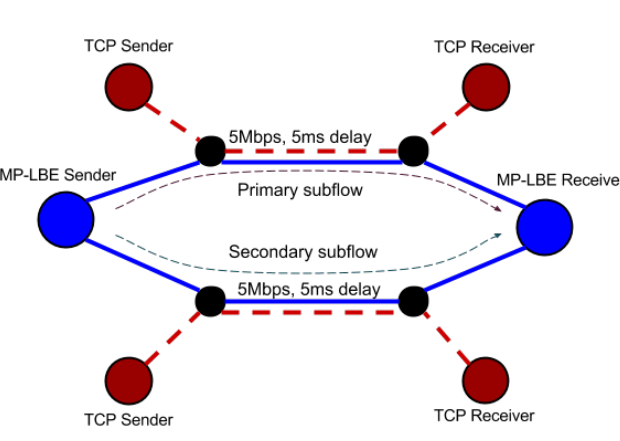
Figure 2. Simulation topology. Each access link directly connected to sender and receiver have 100Mbps capacity, with 5ms delay. Both bottleneck links have 50Mbps capacity with 5ms